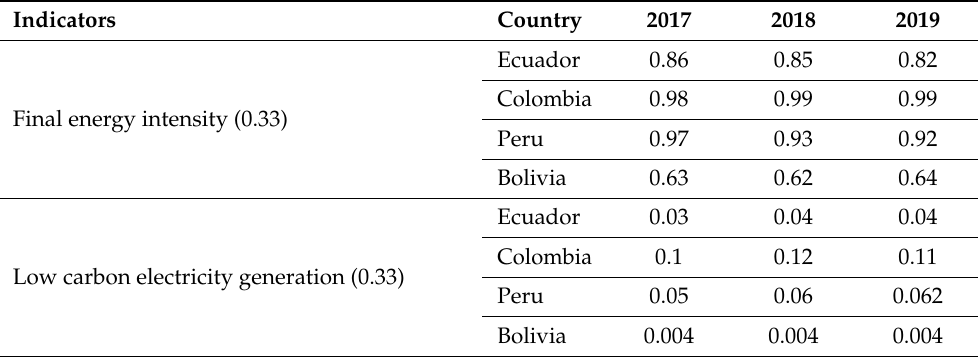
Table 10. The key indicators of the environmental sustainability dimension in the members of the Andean Community